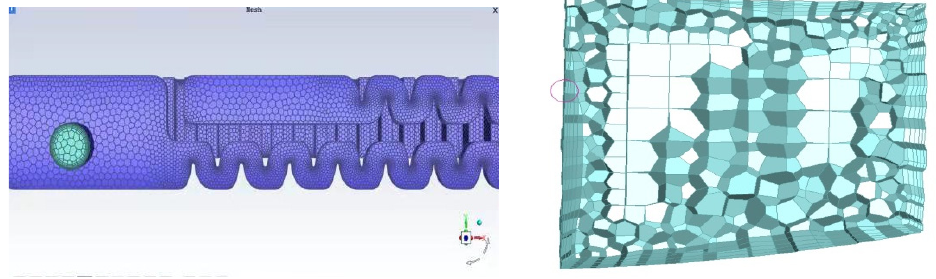
Figure 9. The fluid space body mesh and internal mesh.